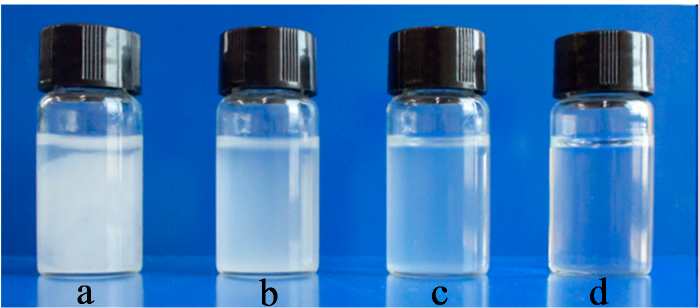
Figure 5. Dispersion states of ( a ) pristine cellulose; ( b ) NaOH/urea-treated cellulose; ( c ) direct TEMPO-oxidized cellulose; and ( d ) NaOH/urea-treated TEMPO-oxidized cellulose.